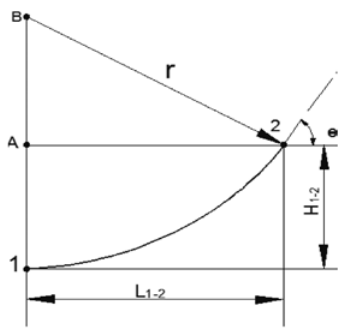
Fig. 4. The diagram of the curvilinear part of a ramp